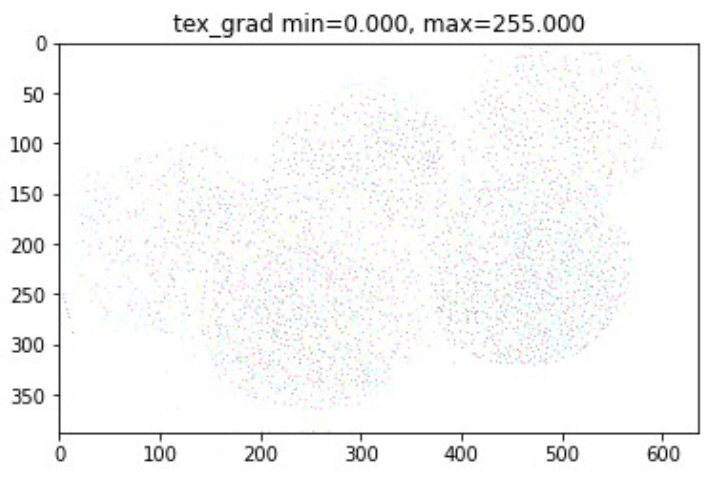
Figure 4. Texture gradient for LBP